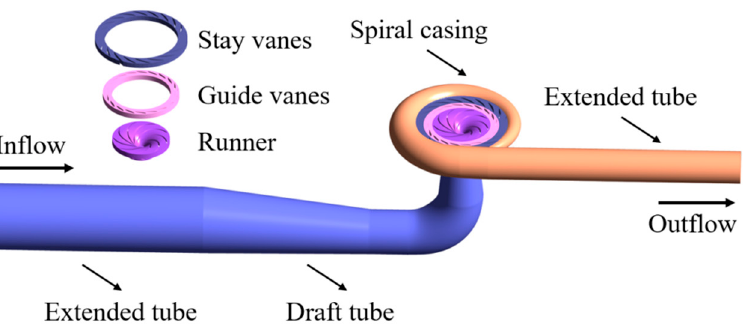
Figure 1. Entire computational domain of the prototype pump-turbine operated in pump mode.